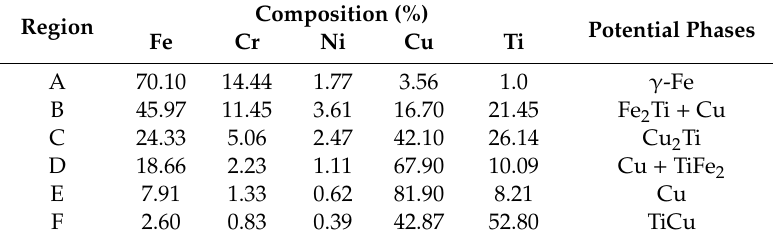
Table 5. Spot EDS analysis of 301L / Cu / TA2 welded joints.